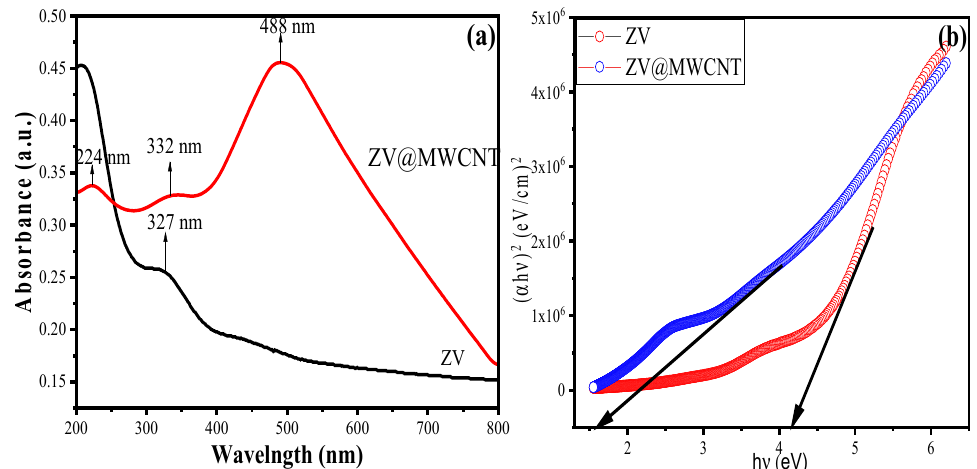
Figure 6. ( a ) UV-Vis spectra of ZV and ZV@MWCNT ( b ) corresponding Tauc’s plot for calculation of energy bandgap.